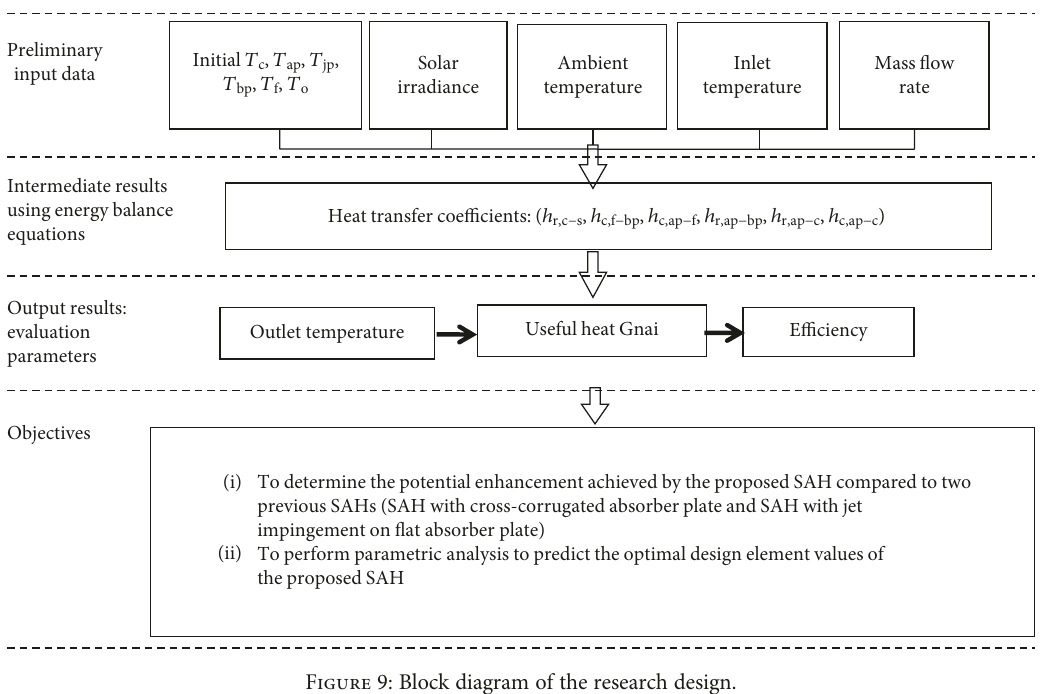
Figure 9: Block diagram of the research design.